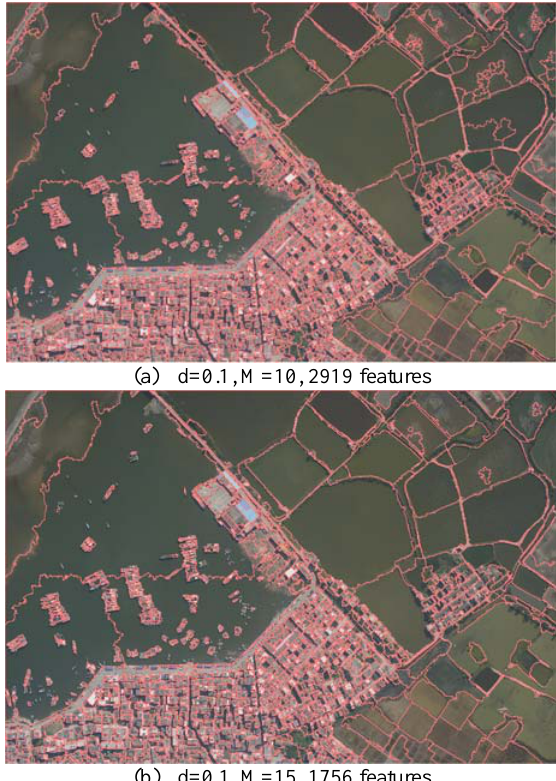
Fig.3 Segmentation results by the Rule I.